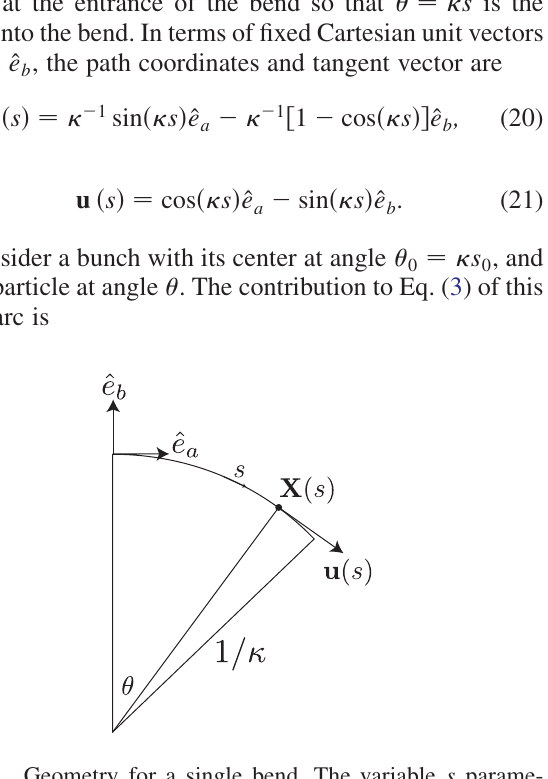
FIG. 1. Geometry for a single bend. The variable s parame- trizes the curve with radius 1 =(cid:7) . The coordinates are X ð s Þ , and the unit tangent vector is u ð s Þ